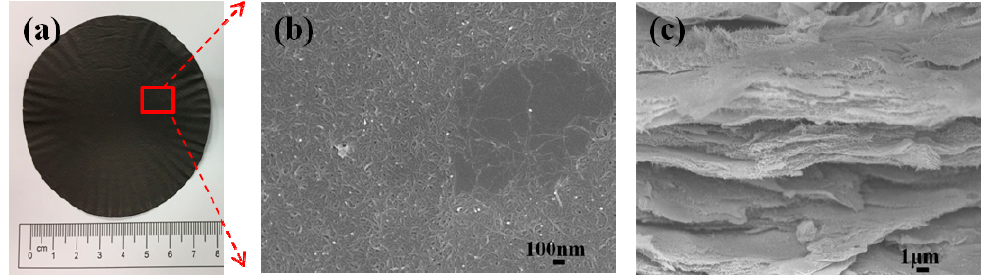
Figure 5. GNP-50 film with 50 wt% graphene and 50 wt% MWCNT; ( a ) the prepared film, ( b ) surface morphology SEM image, and ( c ) cross-section SEM image.